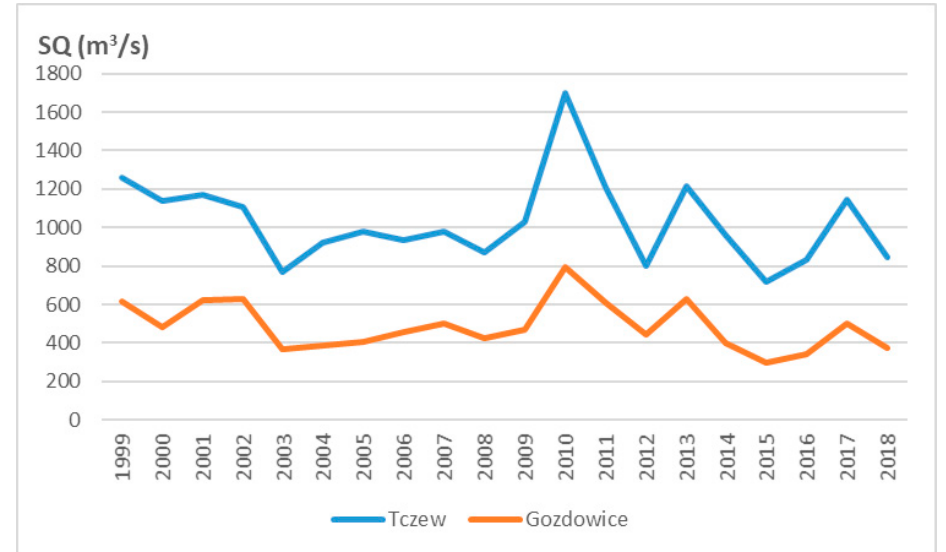
Figure 4. Average annual flows (SQ) of the Vistula in Tczew and the Oder in Gozdowice in the period 1999–2018 (based on Institute of Meteorology and Water Management—National Research Institute data).